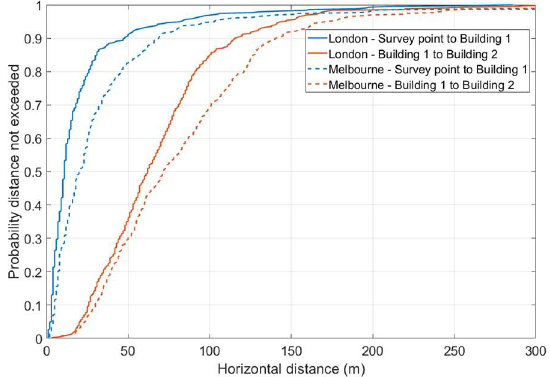
Figure 1. Scheme used to calculate the urban statistics. D b 1 represents, for each ray, the horizontal distance between the base station and the façade of the first building along the ray path; D b 12 is the horizontal distance between the façade of the first building and that of the second building along the ray path. D b 1 and D b 12 are calculated for each ray leaving the base station (with a radial step of 10 degrees), which is placed in a number of survey points in the city close to a building façade and at a height of 5–6 m above the ground. The roof height, H b 1 , at which the radial intersects the building façade is also recorded.